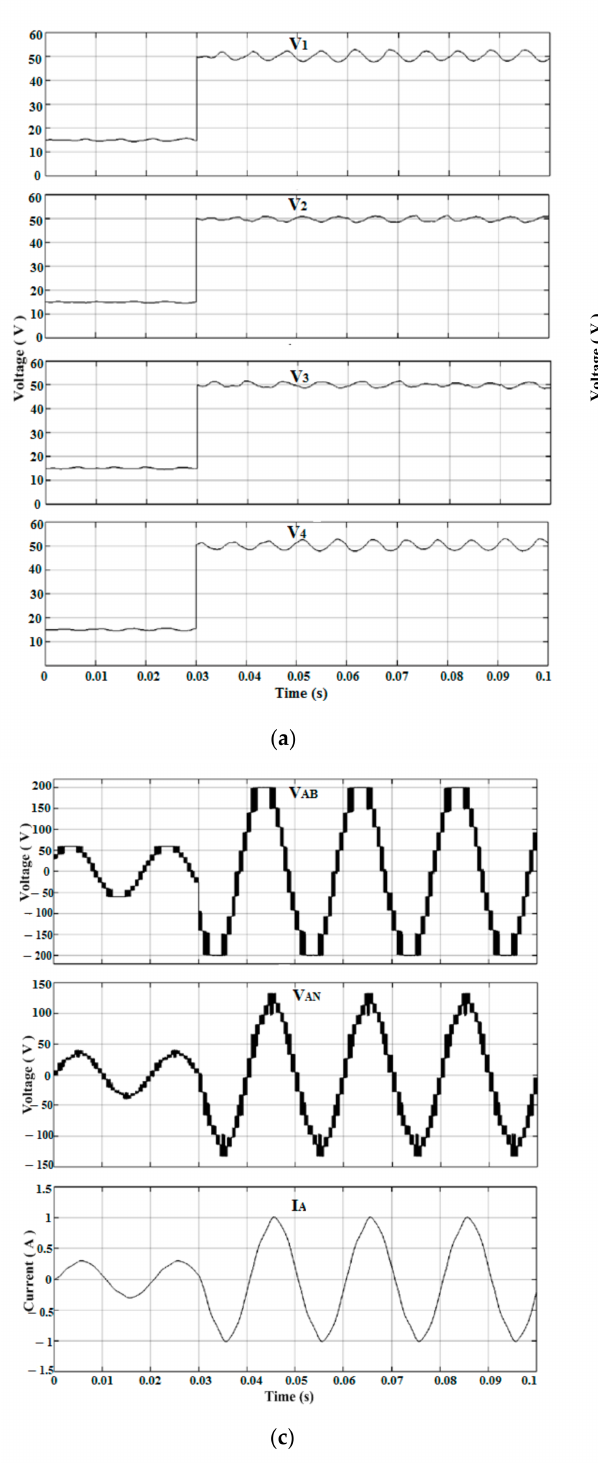
Figure 8. Simulation results without online tuning for a step response with V in changes from 60 V to 200 V. ( a ) Capacitor voltages (V 1 , V 2 , V 3 , V 4 ) for step-up response. ( b ) Capacitor voltages (V 1 , V 2 , V 3 , V 4 ) for step-down response. ( c ) Line-to-line output voltage (V AB ), phase voltage (V AN ) and output current (I A ). ( d ) Output current